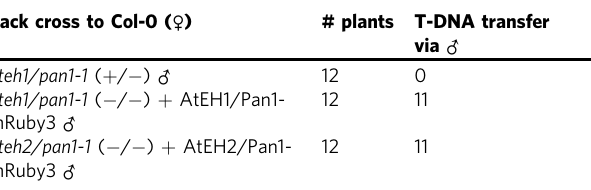
Table 1 Back-cross experiments of ateh1/pan1-1 and ateh2/ pan1-1 plants expressing C-terminal fusions with mRuby3 allow transfer of the T-DNA via the